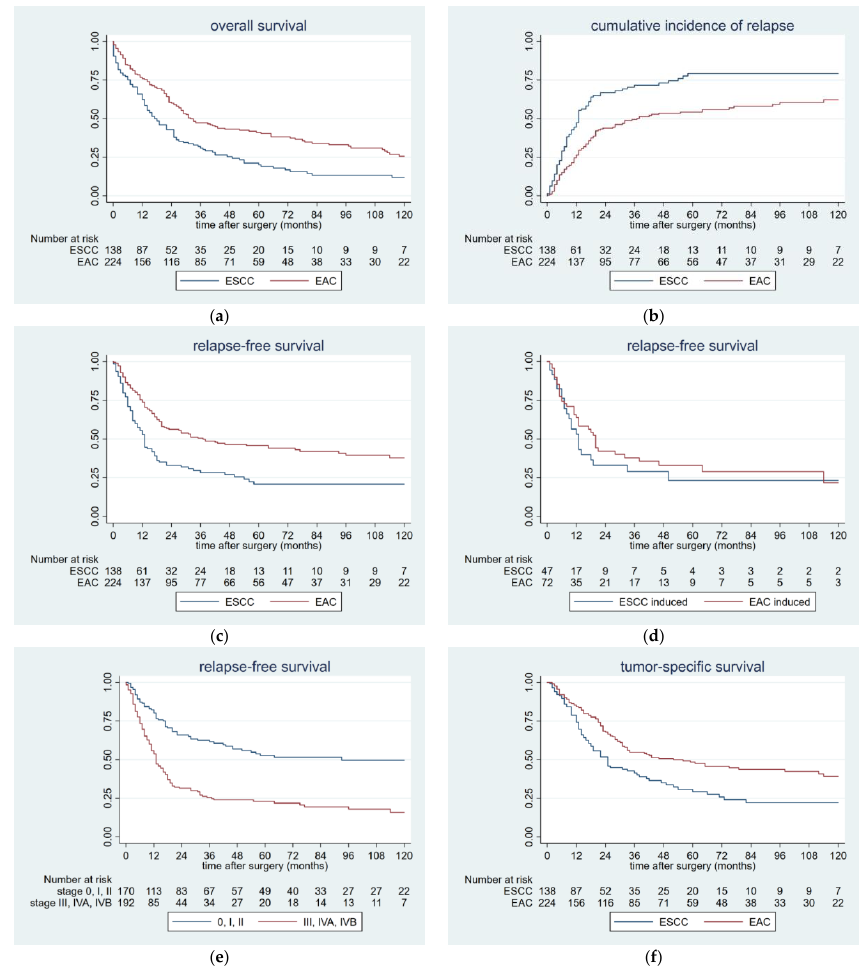
Figure 1. ( a ) Kaplan-Meier-curves showing the relationship between OS and histology in 362 patients with resected esophageal cancer ( p < 0.0001, Cox proportional hazard model, univariate analysis). ( b ) Times of postoperative tumor recurrence in 362 patients with resected esophageal cancer stratified by histology ( p < 0.0001, Cox proportional hazard model, univariate analysis). ( c ) Kaplan-Meier-curves comparing RFS and histology in 362 patients with resected esophageal cancer ( p < 0.0001, Cox proportional hazard model, univariate analysis). d ) Kaplan-Meier-curves comparing RFS and histology in 119 patients with resected esophageal cancer and induction therapy ( p = 0.393, Cox proportional hazard model, univariate analysis). ( e ) Kaplan-Meier-curves comparing RFS and tumor stage in 362 patients with resected esophageal cancer ( p < 0.0001, Cox proportional hazard model, univariate analysis). ( f ) Kaplan-Meier-curves showing the relationship between TSS and histology in 362 patients with resected esophageal cancer ( p < 0.0001, Cox proportional hazard model, univariate analysis). Abbreviations: OS: Overall survival, EAC: esophageal adenocarcinoma, ESCC: esophageal squamous-cell carcinoma, RFS: Relapse free survival, TSS: Tumor specific survival. 2.3. Risk Factors for Postoperative Tumor Recurrence Univariate and multivariate analysis of risk factors for the development of postoperative tumor recurrence are displayed in detail in Table 2. The different parameters are presented with respect to the RFS. After application of multivariate analysis, tumor histology, advanced tumor stage, poor